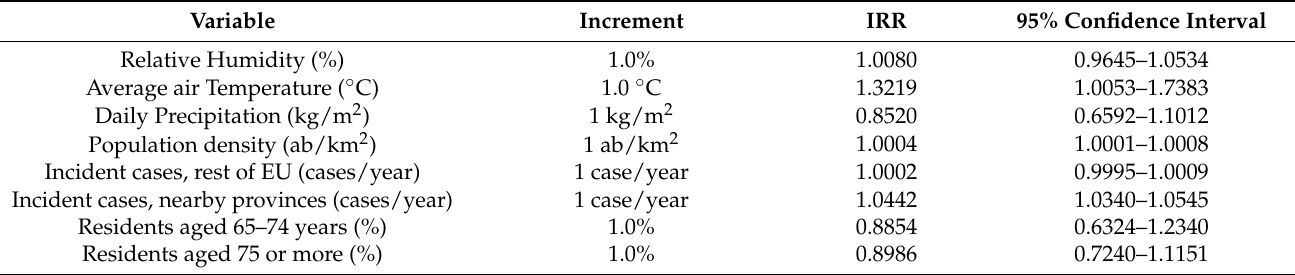
Table 6. Incidence rate ratios (IRR) for West Nile neuro-invasive disease (WNND) cases in Italy (2012–2018) by meteorological factors, and main characteristics of the index areas. IRR were calculated by means of a Poisson logistic regression assuming as outcome variable the annual incident cases of